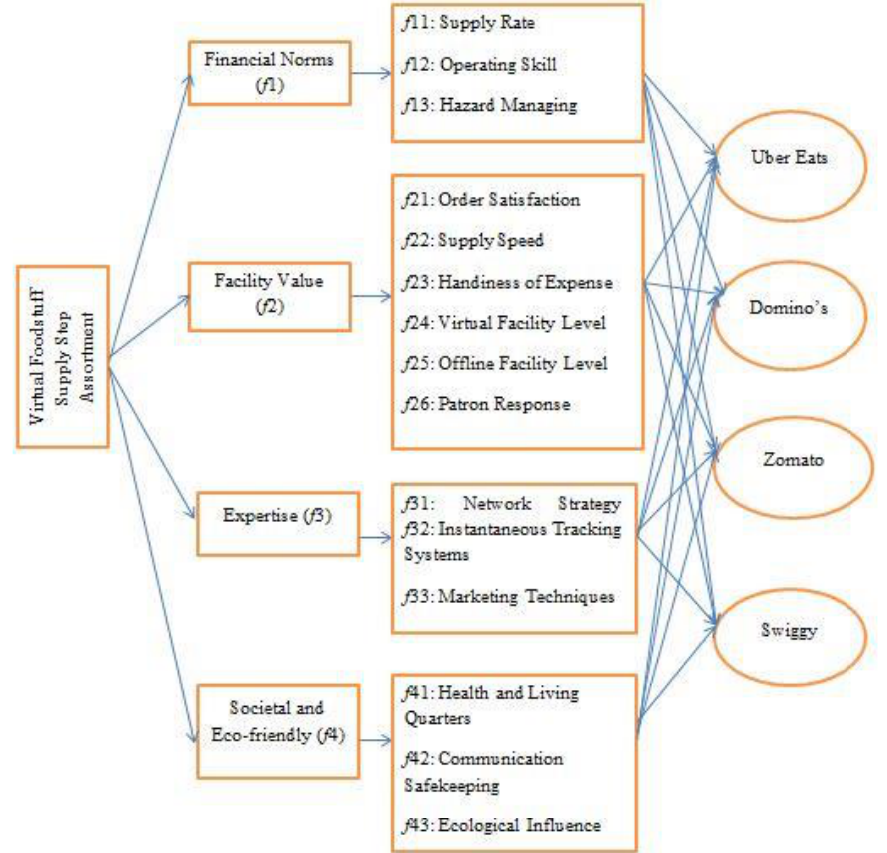
Figure 4. Evaluation and Selection of online food delivery using a decision hierarchy.